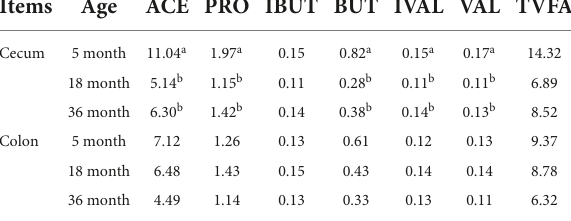
TABLE 1 The VFA concentrations (mmol/L) in the cecum and colon of Mongolian cattle in the different age groups. Items